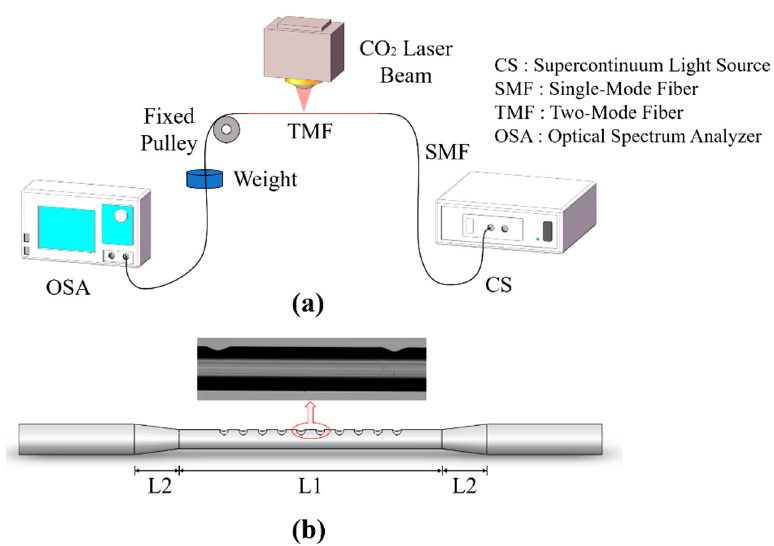
Figure 4. ( a ) Schematic diagram of the BLPFG preparation. ( b ) Schematic diagram of the BLPFG and micrograph of one period in the taper waist.